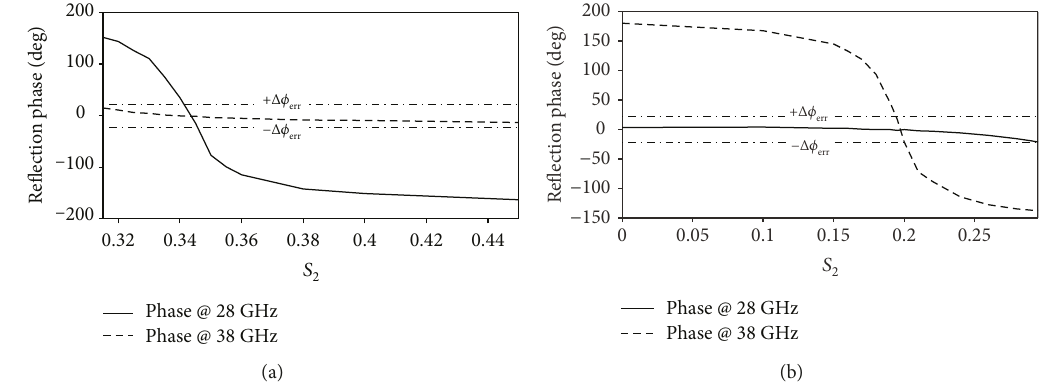
S 1 and 2 , at the two operating frequencies: (a) = 1 91mm , S = variable . 2 2